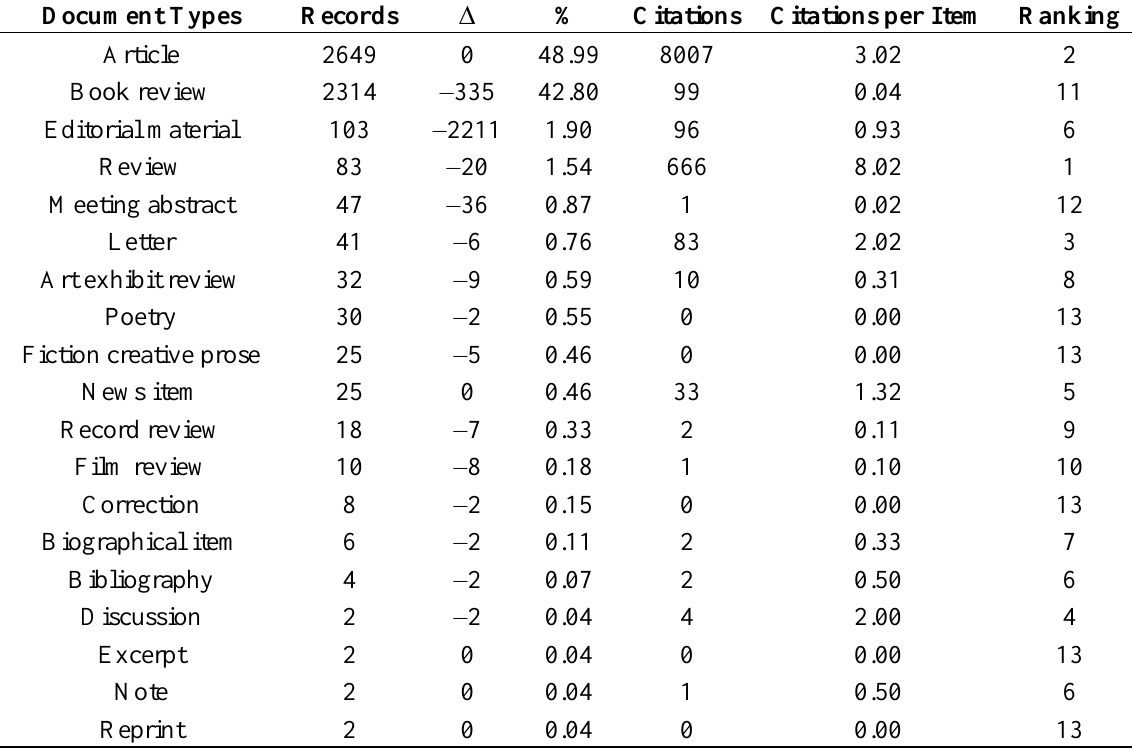
Table 4. Document type-wise distribution in order of number of scholarly communications (minimum record count = 2) and citation analysis of Buddhism and Buddhist studies (1993 and